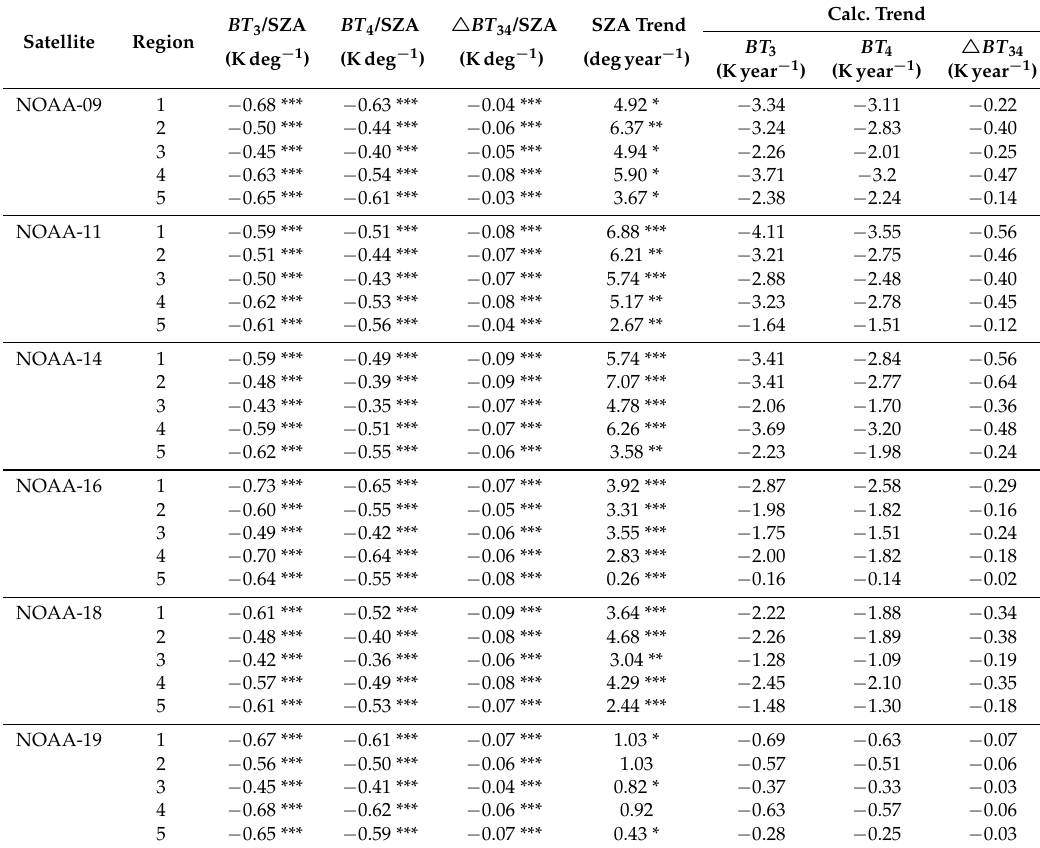
Table 2. Interannual changes in sun zenith angle (SZA) related to background temperatures. For each region, we show the correlation of the monthly mean SZA with the BT 3 , BT 4 , and (cid:52) BT 34 and the monthly mean SZA trends of July of the afternoon platforms NOAA-09, -11, -14, -16, -18, and -19. Significant trends are denoted by asterisks (* p ≤ 0.05, ** p ≤ 0.01, *** p ≤ 0.001). Based on these trends, we calculated the July trends in BT 3 , BT 4 , and (cid:52) BT 34 over the lifetime of each platform under the assumption that all other conditions remain